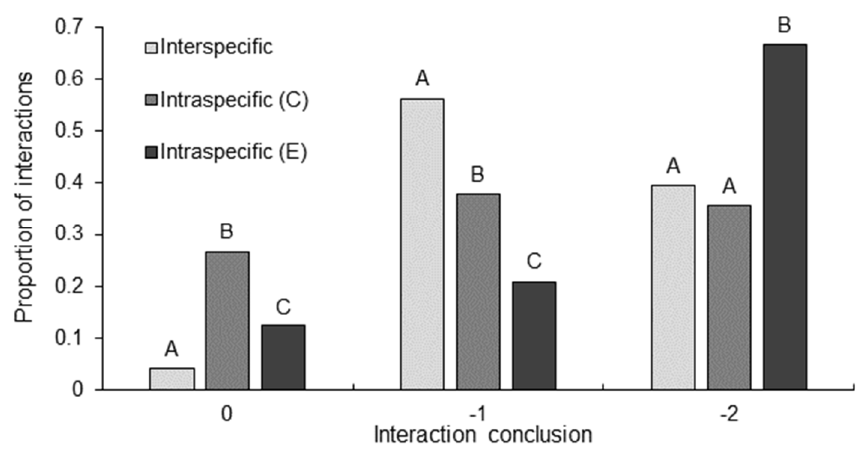
Figure 3. Proportion of interactions that concluded with ignore (0), back away ( − 1) or tailflip away ( − 2) in interspecific interactions Euastacus dharawalus and Cherax destructor , intraspecific interactions between C. destructor (C) and intraspecific interaction between E. dharawalus (E). Different letters denote significant differences between the interaction types for each conclusion level based on the Marascuilo procedure for multiple comparisons of proportions.